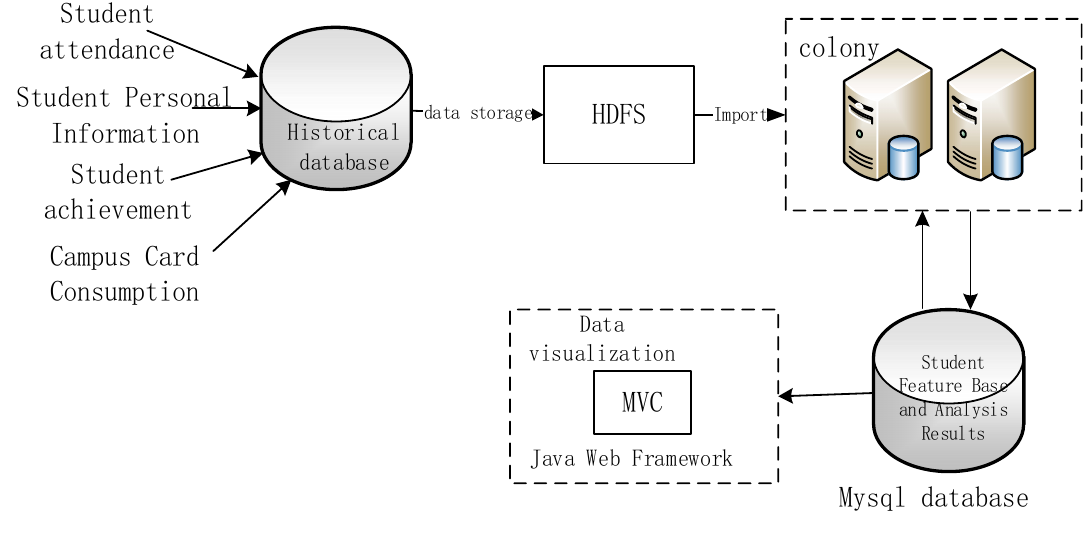
Figure 1. Systems Overall Business